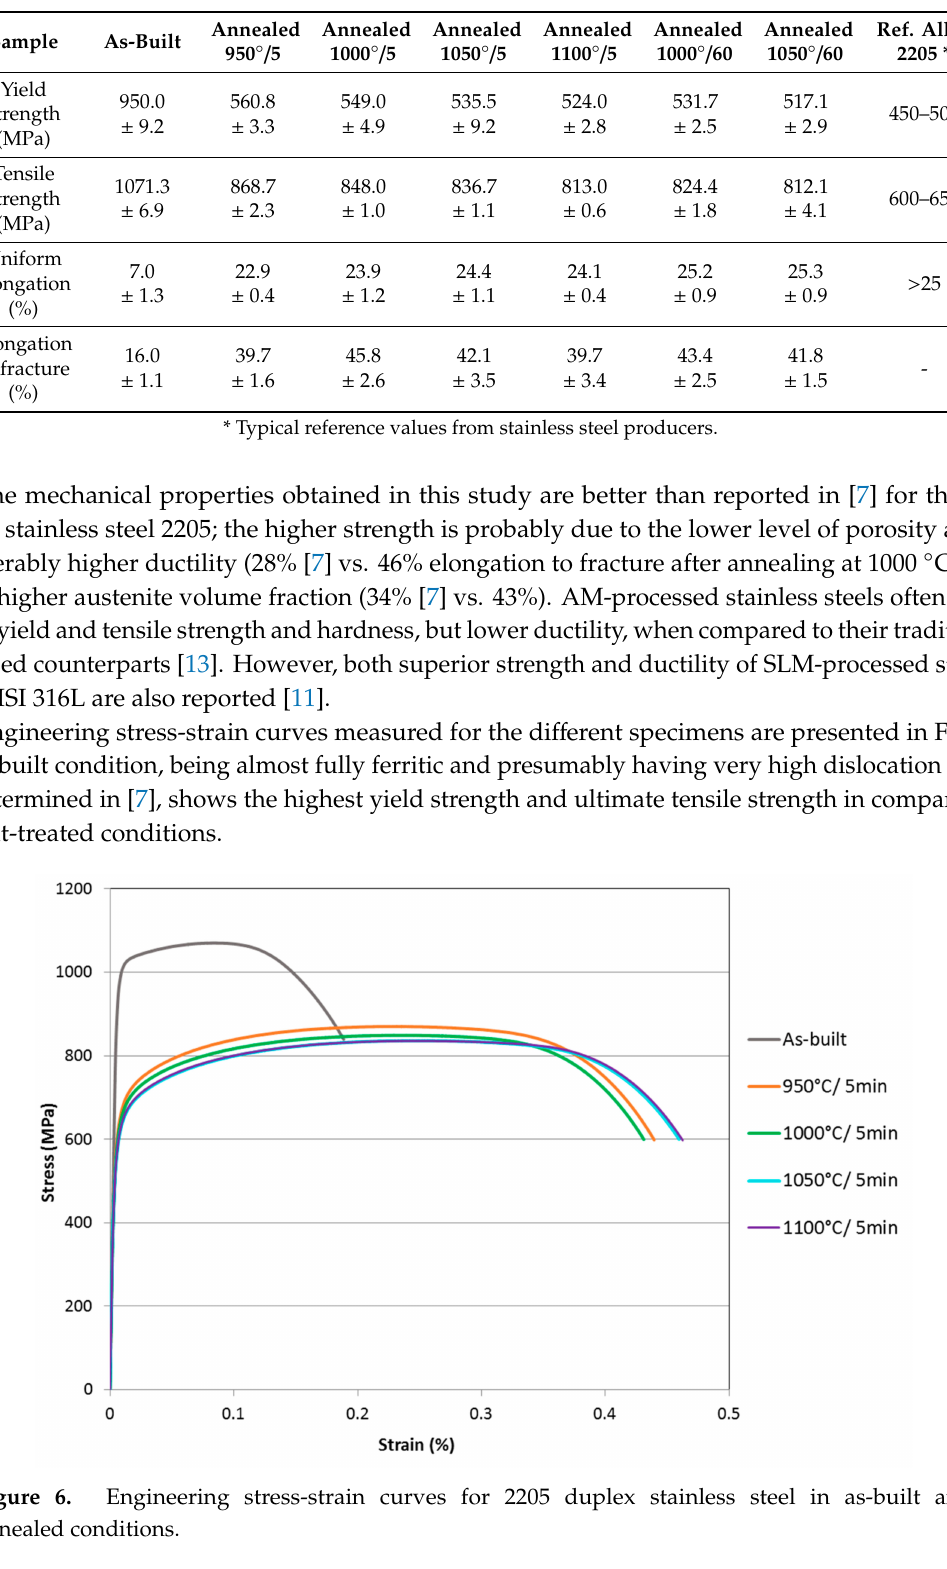
Table 4. Tensile mechanical properties of the test materials, with standard deviation of the results.